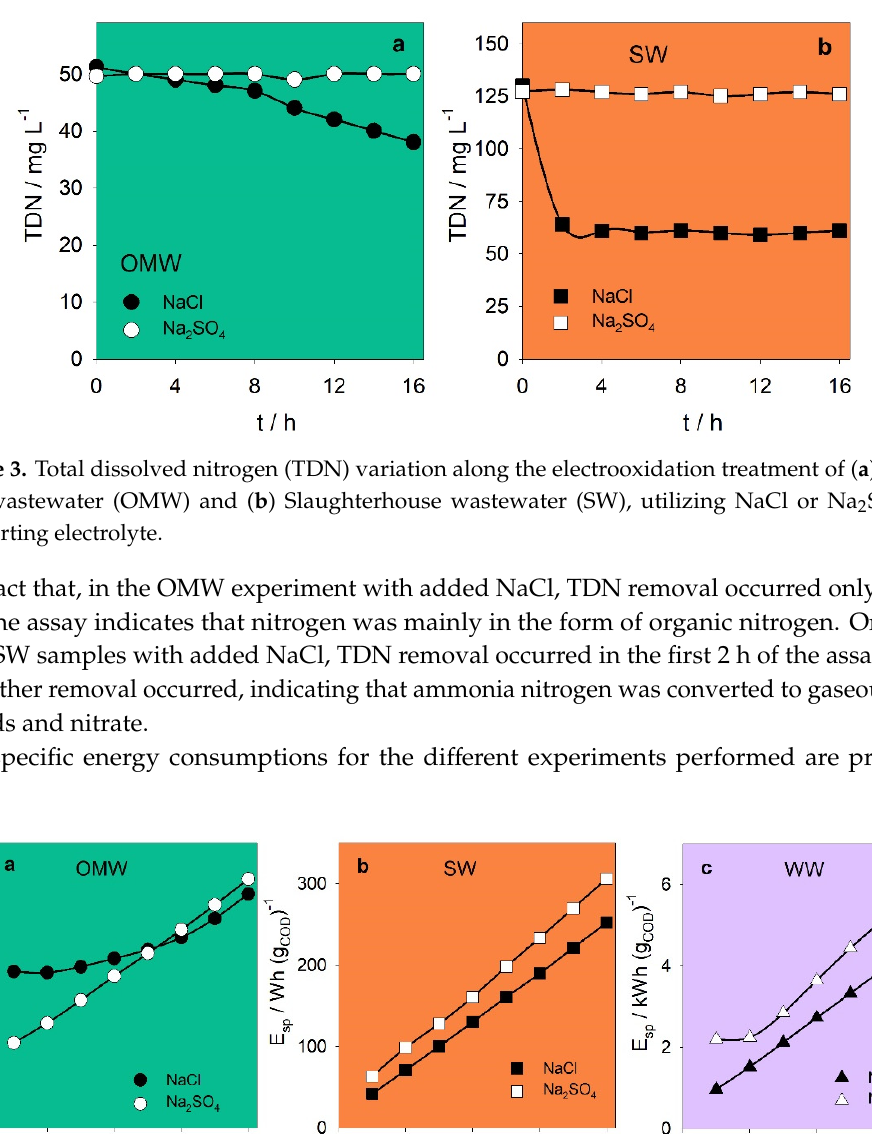
Figure 4. Specific energy consumption evolution for the electrooxidation treatment of ( a ) Olive mill wastewater (OMW), ( b ) Slaughterhouse wastewater (SW), and ( c ) Winery wastewater (WW), utilizing NaCl or Na 2 SO 4 as supporting electrolyte.